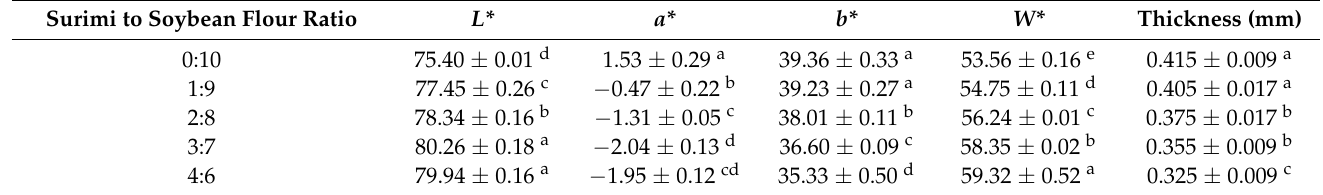
Table 1. Color parameters and thickness of extrudates with different surimi to soybean flour